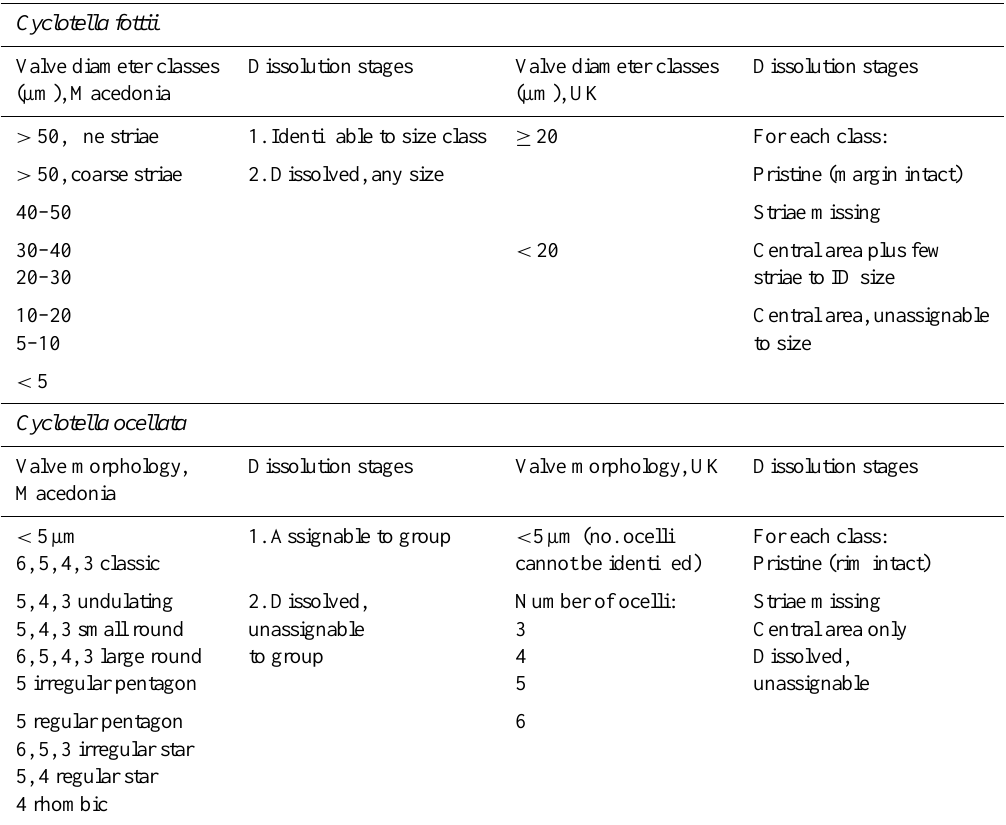
Table 1. Summary of criteria used for taxonomic splitting and dissolution stages of Cyclotella fottii and C. ocellata by laboratories in Macedonia and the